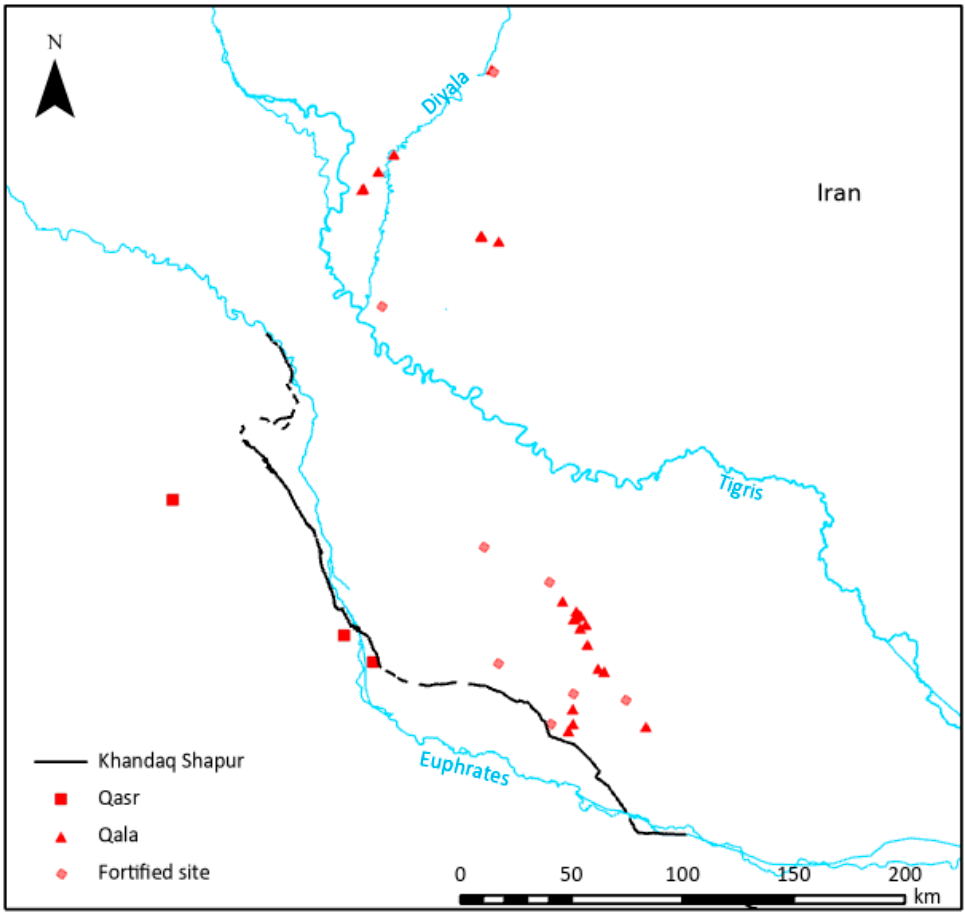
Figure 8. The Khandaq Shapur in relation to the Sasanian defensive landscape. Available evidence suggests the qasrs/castles may have functioned more as diplomatic retreats that were palace-like or elite hunting lodge in nature, more similar to a badiya than a defensive military castle.